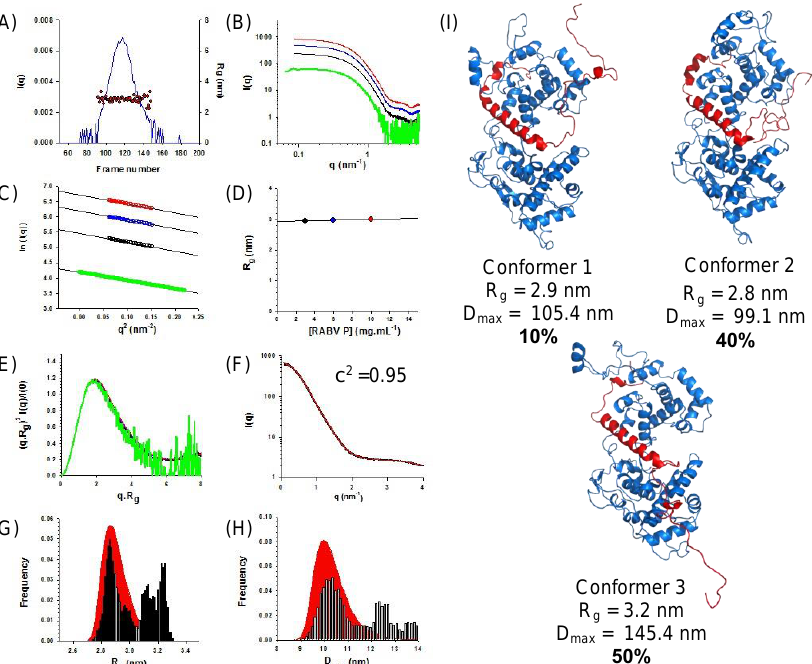
Figure 3. SAXS and SEC-SAXS of RABV N ∆ 230 − P 68 core complex. ( A ) SEC-SAXS elution profile and R g across the elution peak; 50 µ L of the N ∆ 230 − P 68 sample were injected onto a Superdex 200 column and monitored on-line by SAXS. The black line shows the intensity at zero angle (I 0 ), which is proportional to both the MM and concentration. The red dots indicate the values of the radius of gyration calculated from the Guinier approximation at the different time intervals. ( B ) SAXS profiles at different protein concentrations. SAXS profiles were recorded in batch mode at 3 mg.mL − 1 (in black), 6 mg.mL − 1 (in blue), and 11 mg.mL − 1 (in red). The curve in green was obtained by averaging the individual profiles recorded throughout the SEC elution peak shown in Panel ( A ). ( C ) Guinier plots at different protein concentrations. Same color scheme as in panel ( B ). ( D ) Rg at different protein concentrations. The R g value were calculated from the Guinier plot (panel ( C )) for the profiles recorded in batch mode. ( E ) Dimensionless Kratky plots at different protein concentrations. Same color scheme as in panel ( B ). ( F ) Merged curve and conformational ensemble modeling by the ensemble optimization method (EOM). The black line shows the scattering profile obtained by merging segments of the profiles obtained at different protein concentrations (panel ( B )). The red line shows a back-calculated scattering curve for a selected ensemble of three conformers measured in different proportions and shown in panel ( I ) ( χ 2 = 0.95). ( G ) R g distribution. The red area shows the R g distribution calculated for the initial ensemble of conformers, whereas the black bars show the R g distribution of the selected ensemble that fit the experimental SAXS data (panel ( F )). ( H ) D max distribution. The red area shows the D max distribution calculated for the initial ensemble of conformers, whereas the black bars show the D max distribution of the selected ensemble that fit the experimental SAXS data. ( I ) Representative ensemble of conformers. N is shown in blue and P 68 including the eight C-terminal residues of the linker and His-tag are shown in red (cartoon